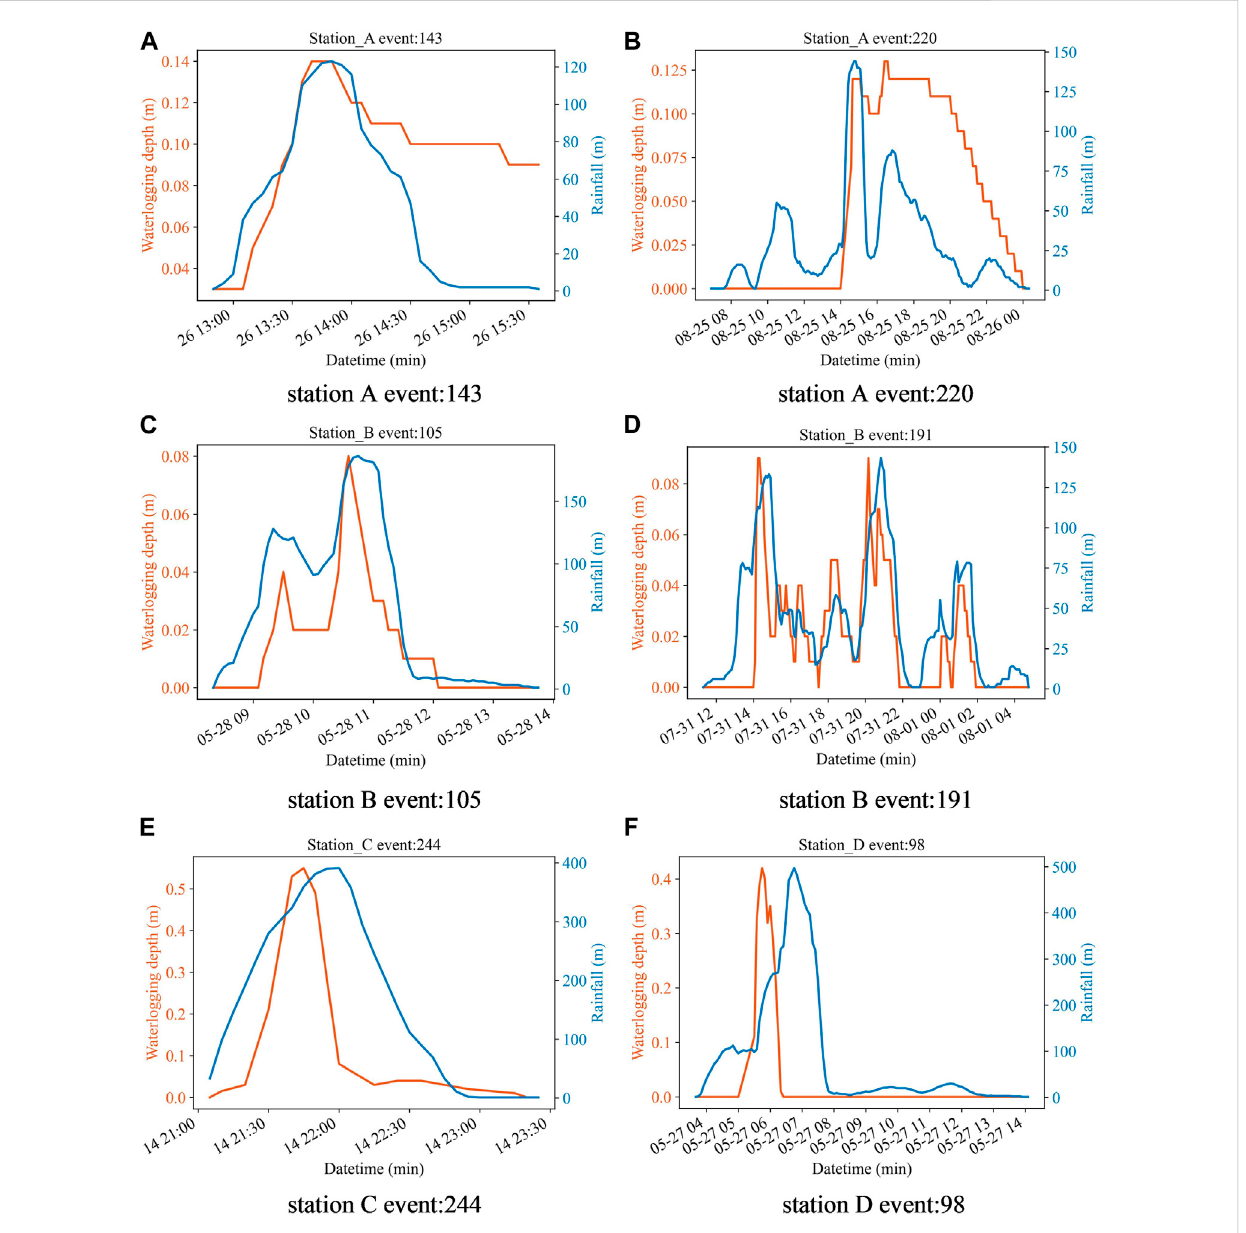
FIGURE 5 Rainfall and waterlogging curves for events in four stations. (A) station A event: 143; (B) station A event: 220; (C) station B event: 105; (D) station B event: 191; (E) station C event: 244; (F) station D event: